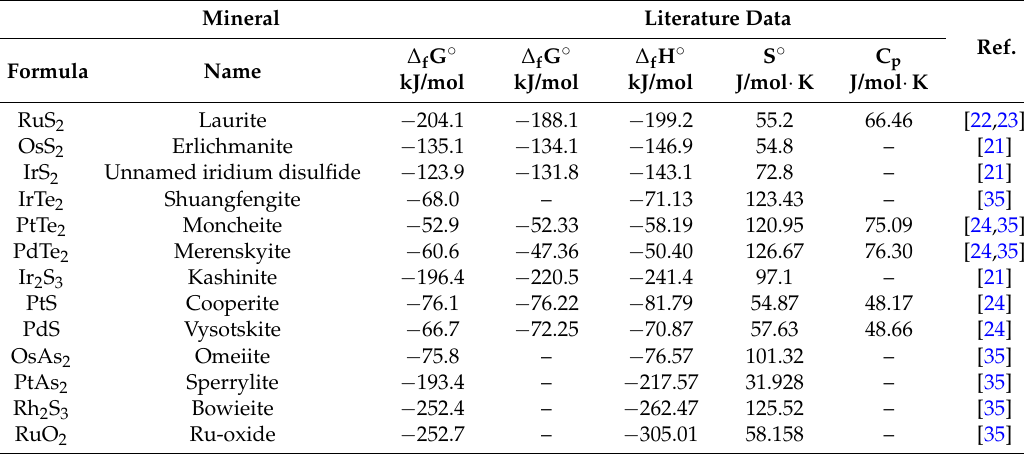
Table 1. The calculated standard Gibbs free energy ( ∆ f G ˝ ) values of formation for platinumgroup minerals are compared to available literature data. Mineral Literature Data